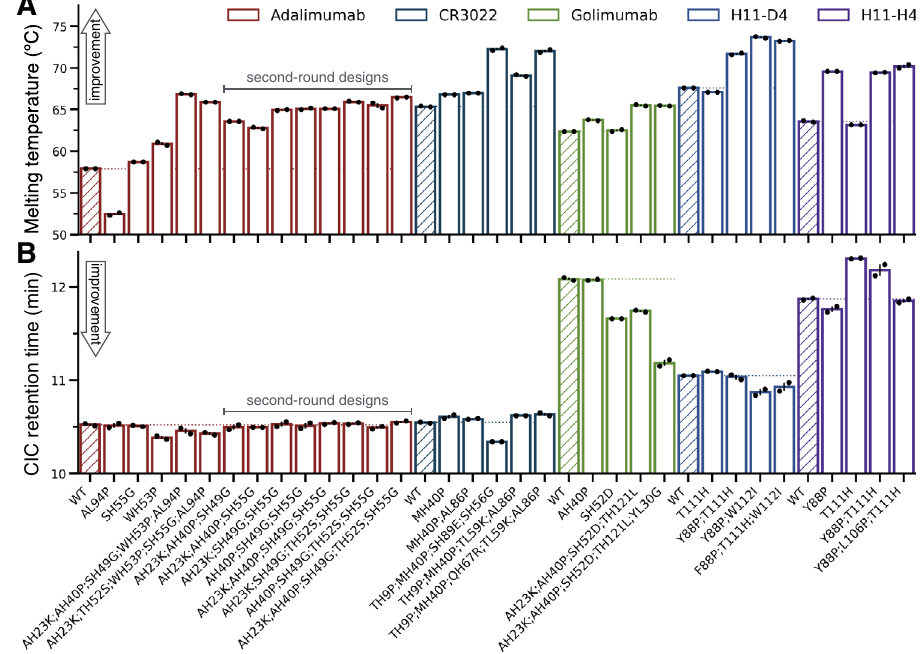
Fig.5|Experimentalcharacterisationofdesignsfrom fi veantibodies.A Barplot of the melting temperature (T m ) for each variant (x-axis labels). B Bar plot of the cross-interaction chromatography (CIC) retention time (RT). In both panels, data from two independent experiments (black points) are reported, and the height of